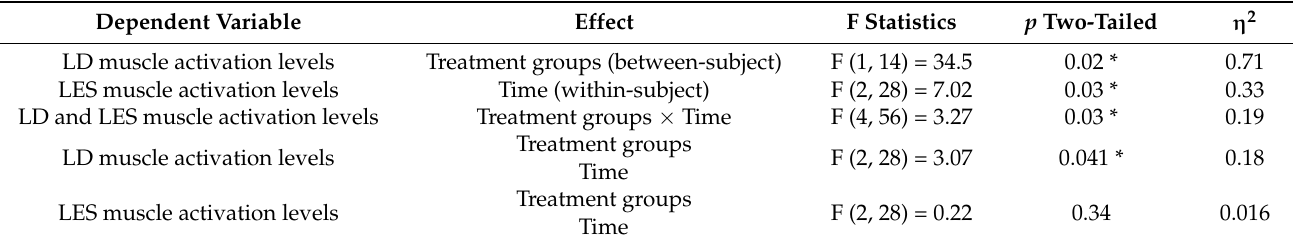
Table 4. Mixed-design repeated measures ANOVA test results with the normal standing posture.